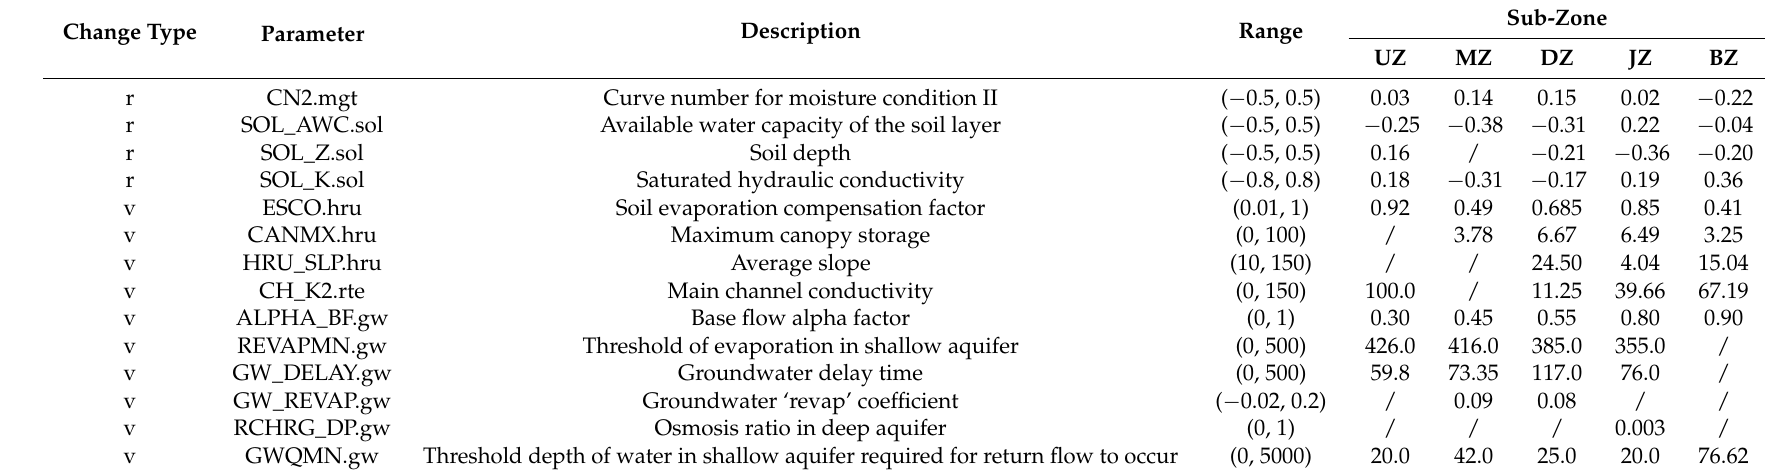
Table 6. Key parameters and best fit values for the five sub-zones.